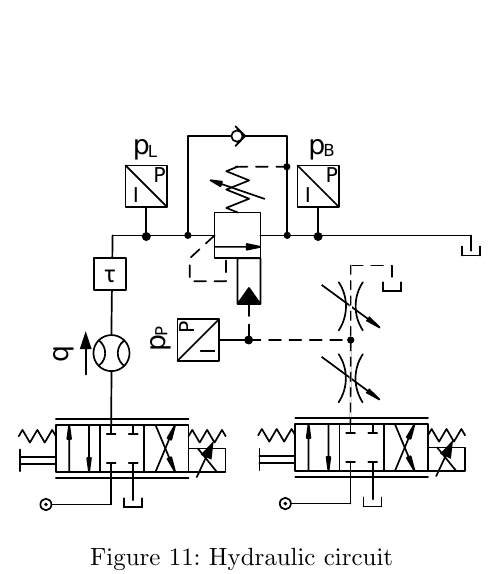
Figure 11: Hydraulic circuit